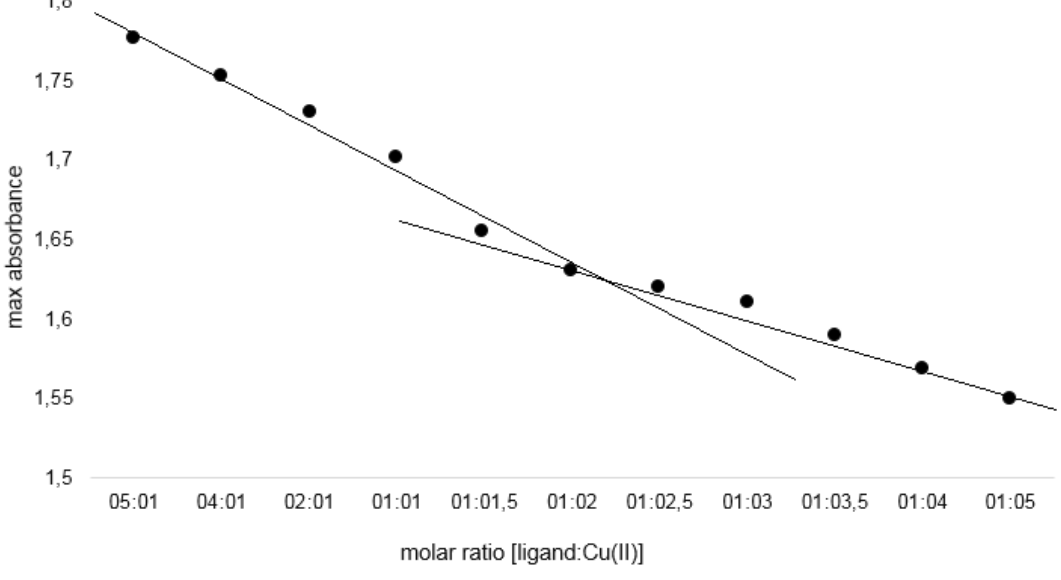
Figure 2. Absorbance as a function of [cichoric acid]: [copper] molar ratio at 320 nm.